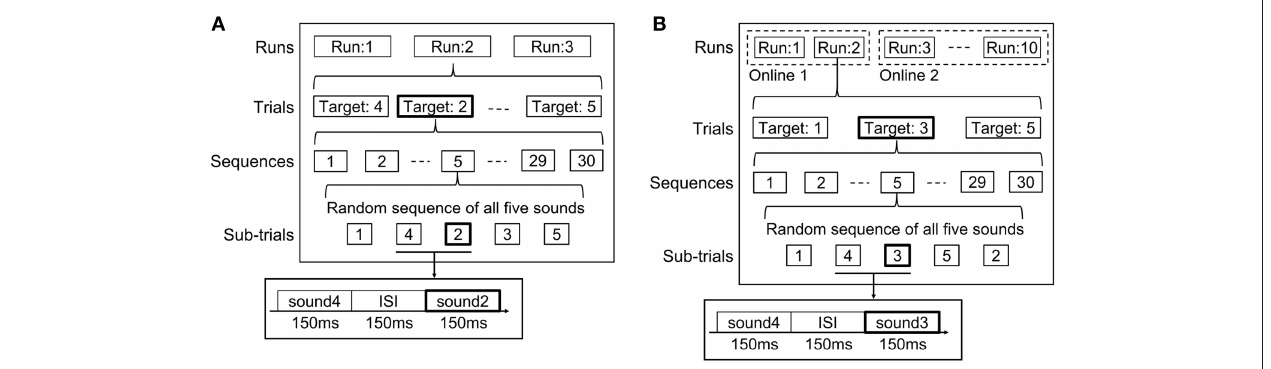
FIGURE 2 | Experimental protocols for one participant in (A) offline analysis and (B) online analyses. Two runs with online data were performed on the same day as the offline analysis (online experiment 1). The other eight runs were conducted 6 months later (online experiment 2). Five natural sounds were randomly presented, and the participants mentally counted the presence of the target sound during EEG